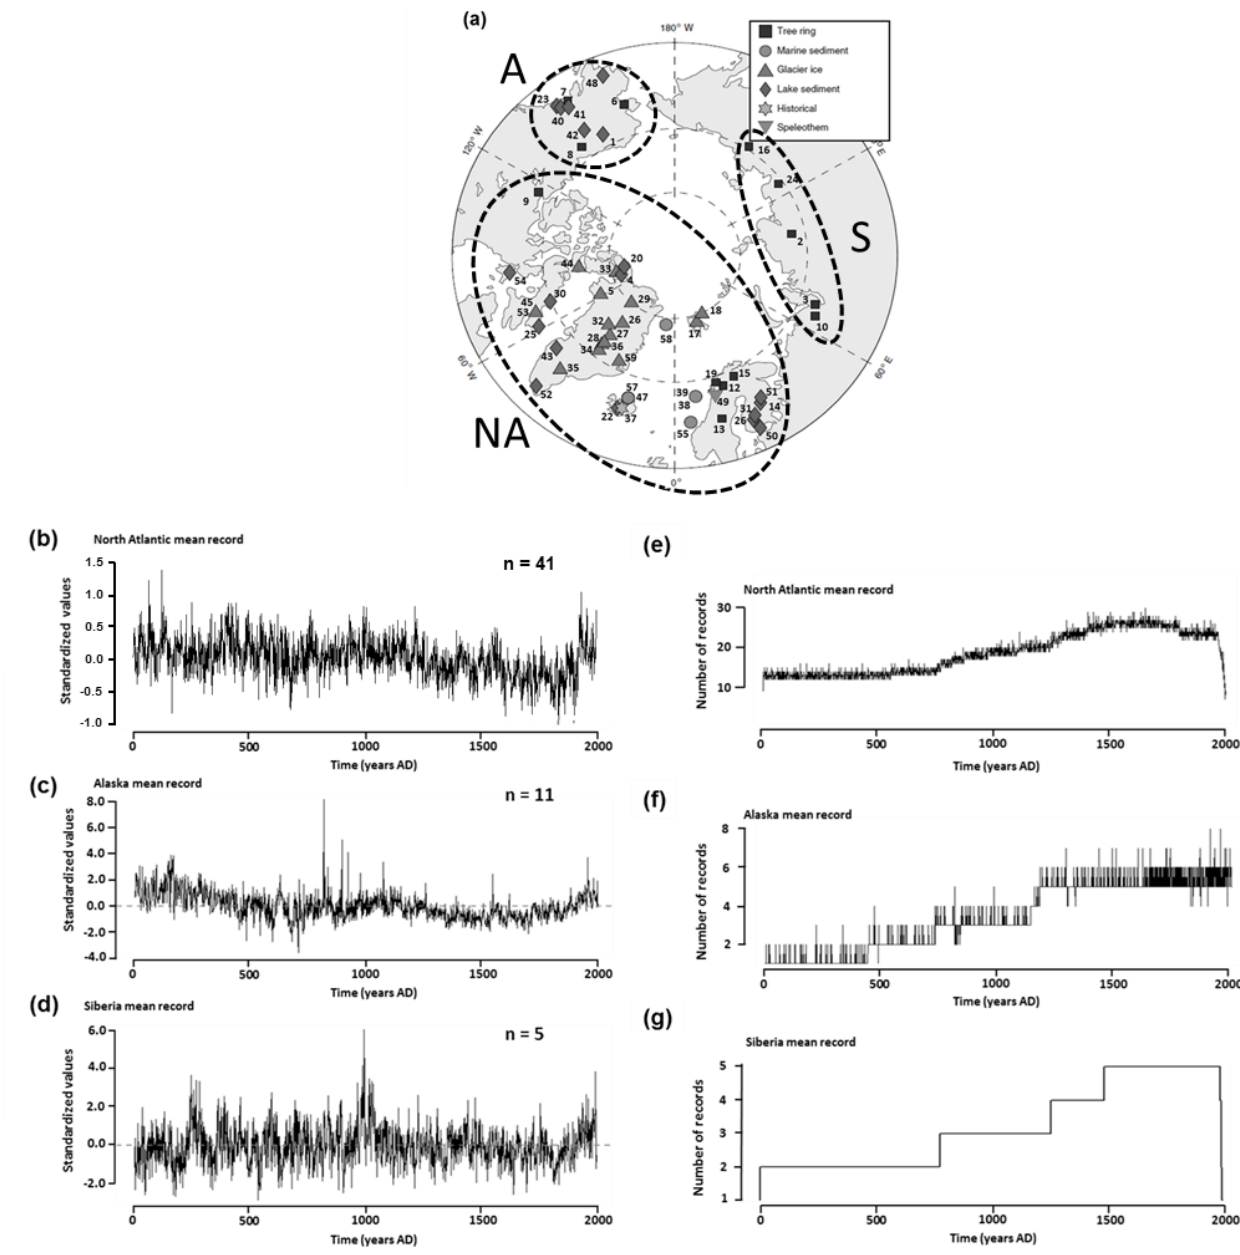
Figure 2. (a) Map of record location (modified from McKay and Kaufman, 2014). Dashed lines show selected area used for calculating the three regional mean records (NA: North Atlantic, A: Alaska and S: Siberia) presented at (b–c) curves. n corresponds to the number of records available in each area. Each regional mean record is associated with a corresponding number of records available for each